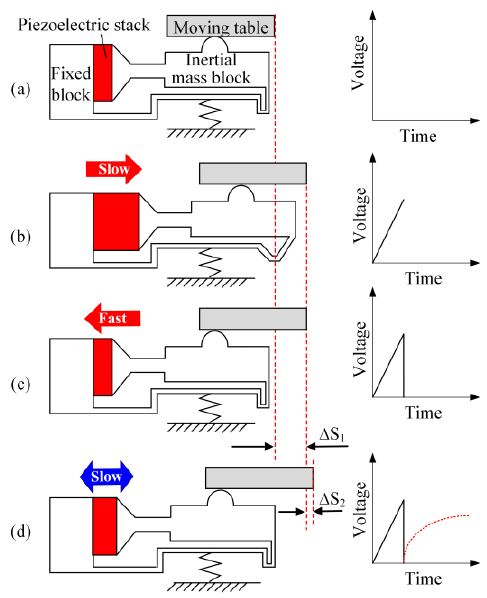
Figure 3. Operation principle of the actuator. ( a ) Ready state. ( b ) Stick phase. ( c ) Slip phase. ( d ) Scan mode.